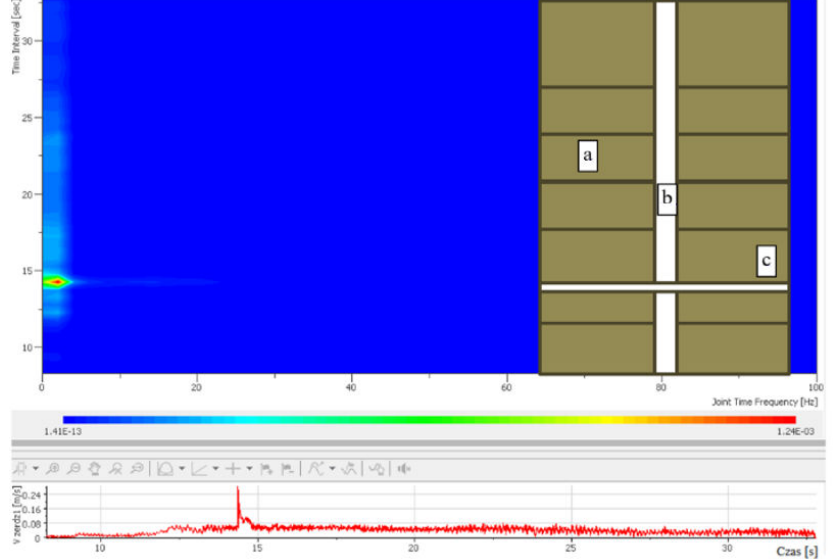
Figure 18. The detected signal on the recorded spectrogram corresponding to the location the critical discontinuity for borehole 1, rod 1—Hanning window, time domain sieve set to 60, calculated WGM; a, rock layer; b, borehole; c, discontinuity.